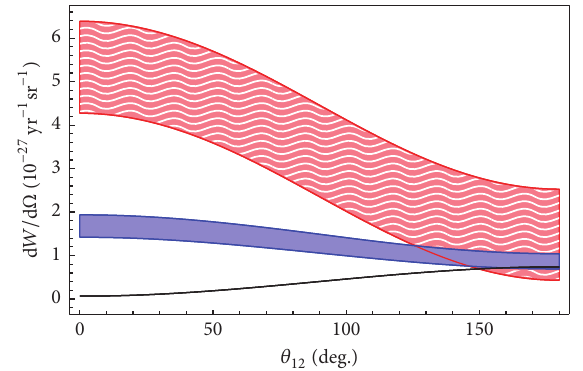
Figure 2: Electrons angular distribution for 124 Sn. The red band corresponds to 𝜂 mechanism and the blue band corresponds to 𝜆 mechanism. The width of the bands represents the uncertainties arising from the unknown CP phases 𝜙 1 and 𝜙 2 .